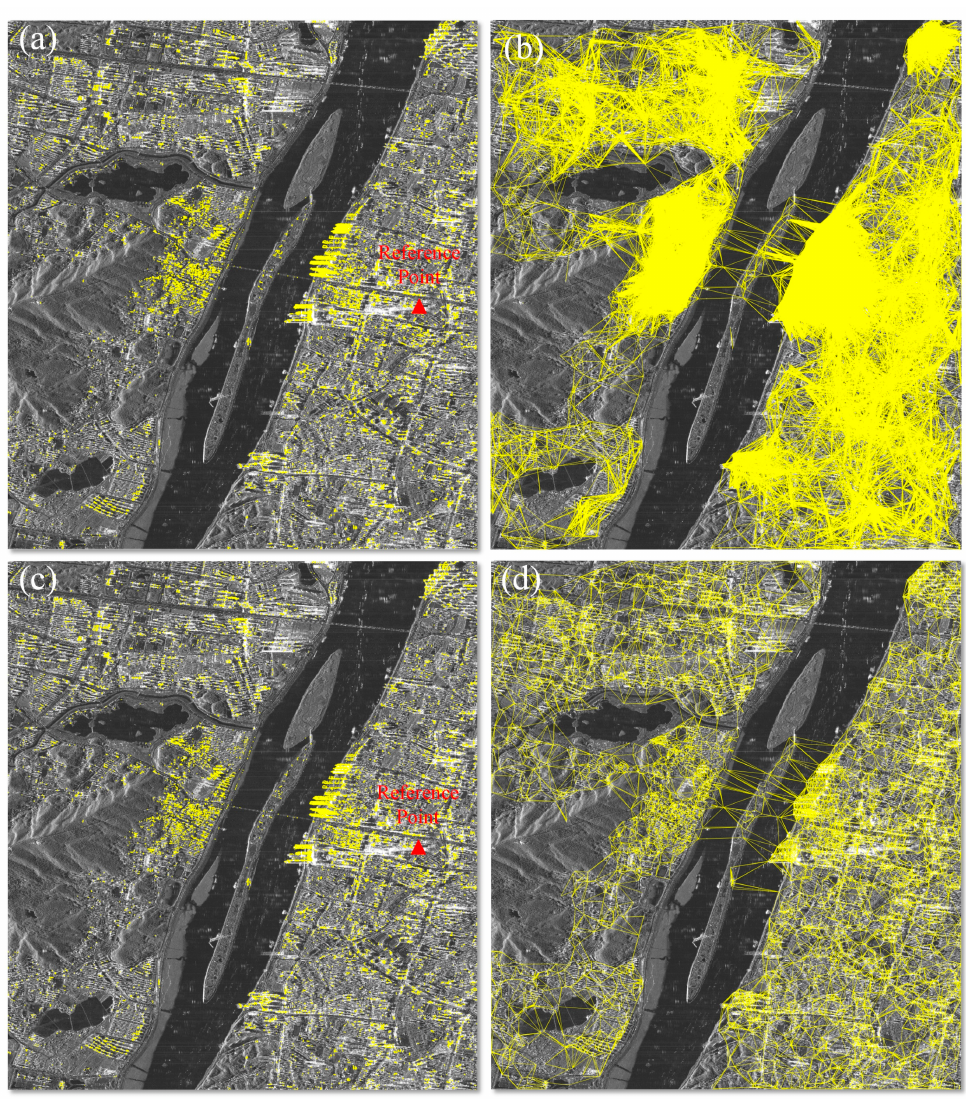
Figure 7. Comparison of PS-DS and baseline network; ( a , b ) before the baseline quality evaluation; ( c , d ) after baseline quality evaluation .